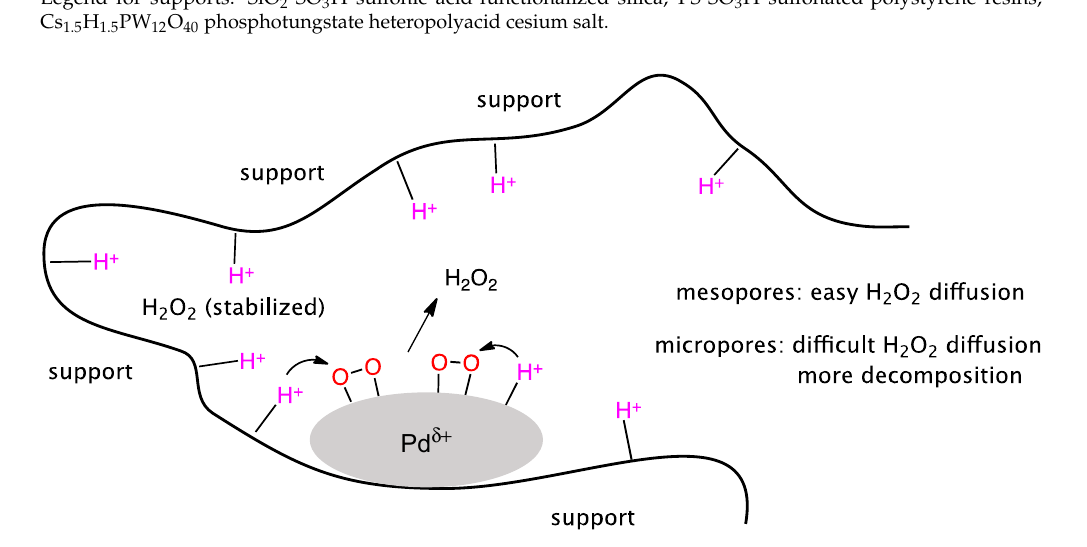
Figure 6. The role of support acidity in stabilizing H 2 O 2 and promoting H 2 O 2 formation. Mesopores facilitate H 2 O 2 back-diffusion decreasing the probability of decomposition.